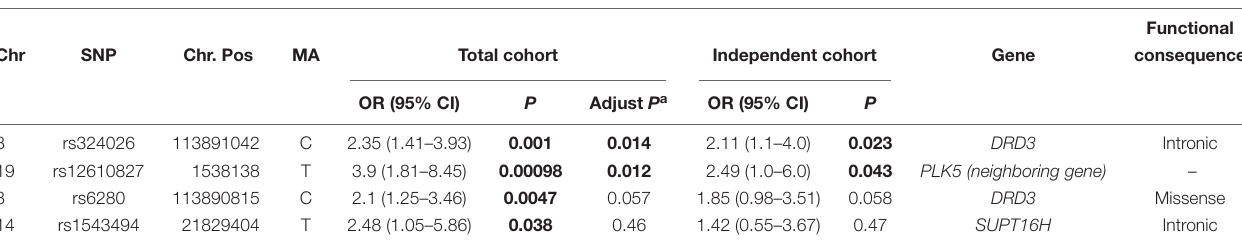
TABLE 3 | Validation of SNPs associated with the olanzapine response.